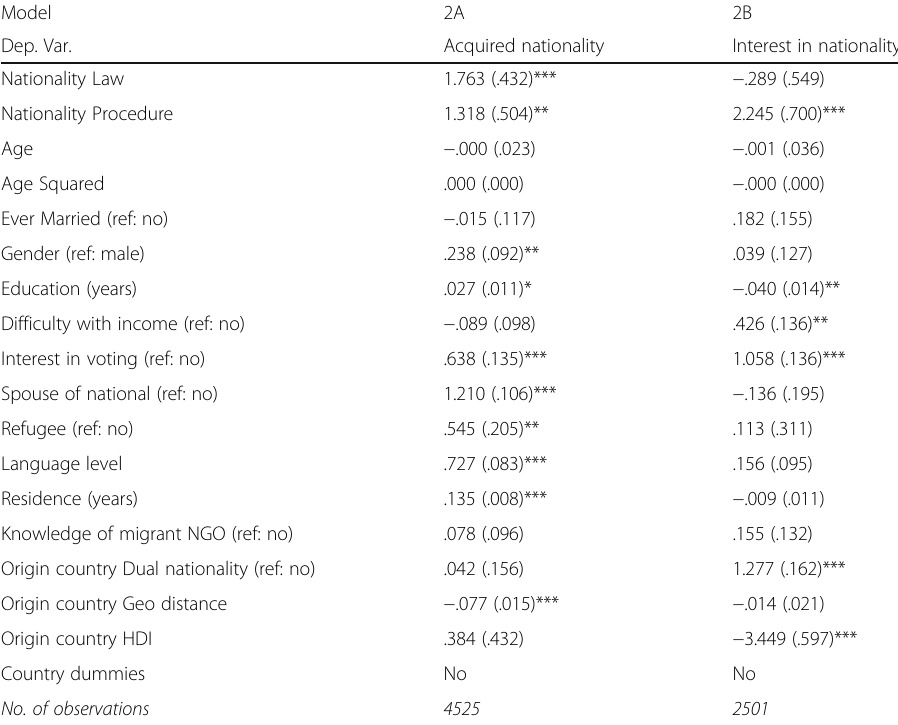
Table 4 Logistic regression of acquisition and interest, including nationality laws and procedures, standardised coefficients Model 2A 2B Dep.